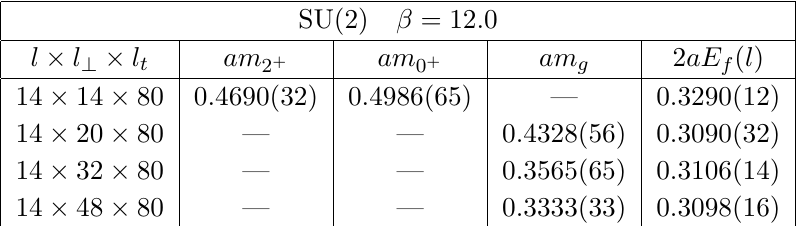
Table 2 . Lightest J P = 2 + ; 0 + glueball masses and the mass gap m g on the spatial lattice volumes shown. Also the energy E f ( l x ) of the lightest fundamental (cid:13)ux tube that winds around the x -torus. In SU(2) at an inverse bare coupling (cid:12) = 4 =ag 2 = 12 : 0.